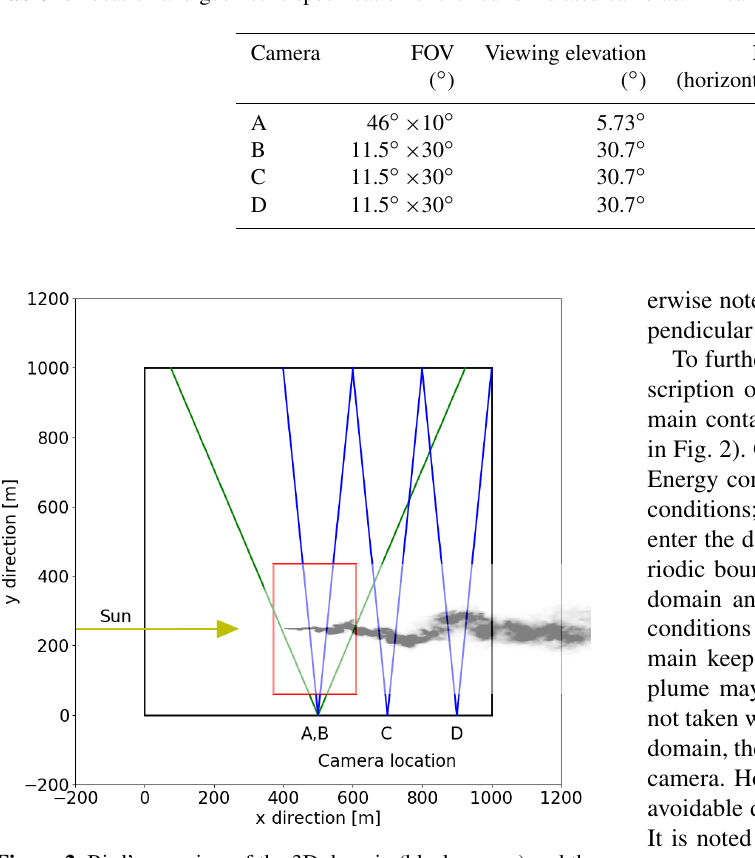
Figure 2. Bird’s eye view of the 3D domain (black square) and the SO 2 plume location within the domain (red square for camera A simulation, shifted along x axis for the other cameras). The UV cameras are located where the two green or blue lines intersect. The lines indicate the horizontal field of view of the cameras, and their locations are given in Table 1. The column density (similar to Fig. 1a) of the plume is included for illustrative purposes. The direction of the incoming sunray is shown by the yellow